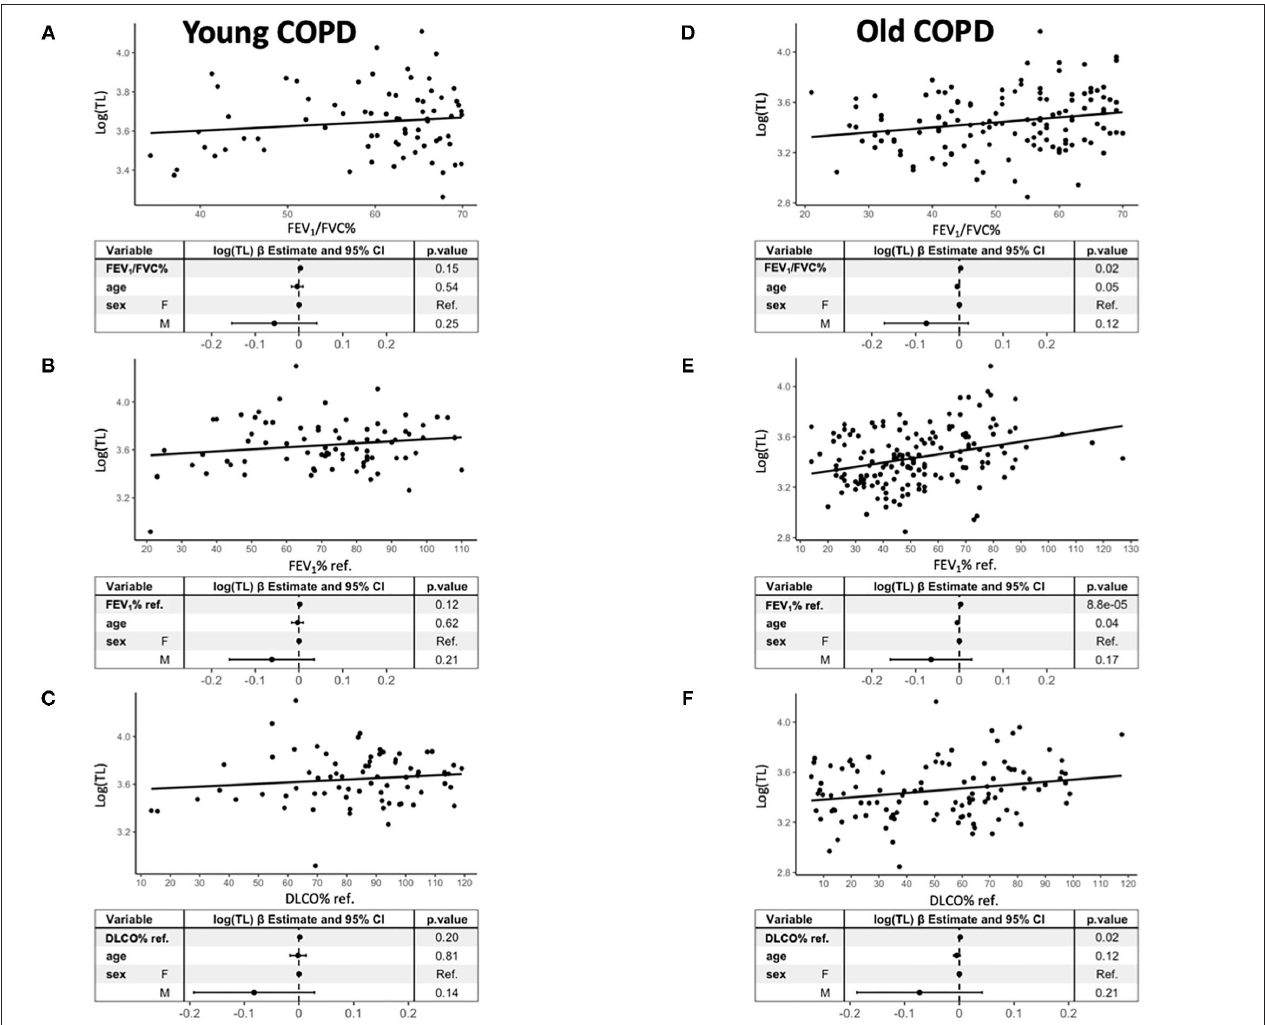
FIGURE 3 | Relationship between TL [log(TL)] and FEV 1 /FVC% (A,D) , FEV 1 % ref. (B,E) , and DLCO% ref. (C,F) in young (left) ( A : n = 81, B : n = 81, C : n = 72) and old (right) patients with COPD ( A : n = 159, B : n = 159, C : n = 108). Forest plots of the linear regression models presenting the point estimates and 95% CI (whiskers) of the change in log(TL) when adjusted for the potential confounders. For further explanations, see text.